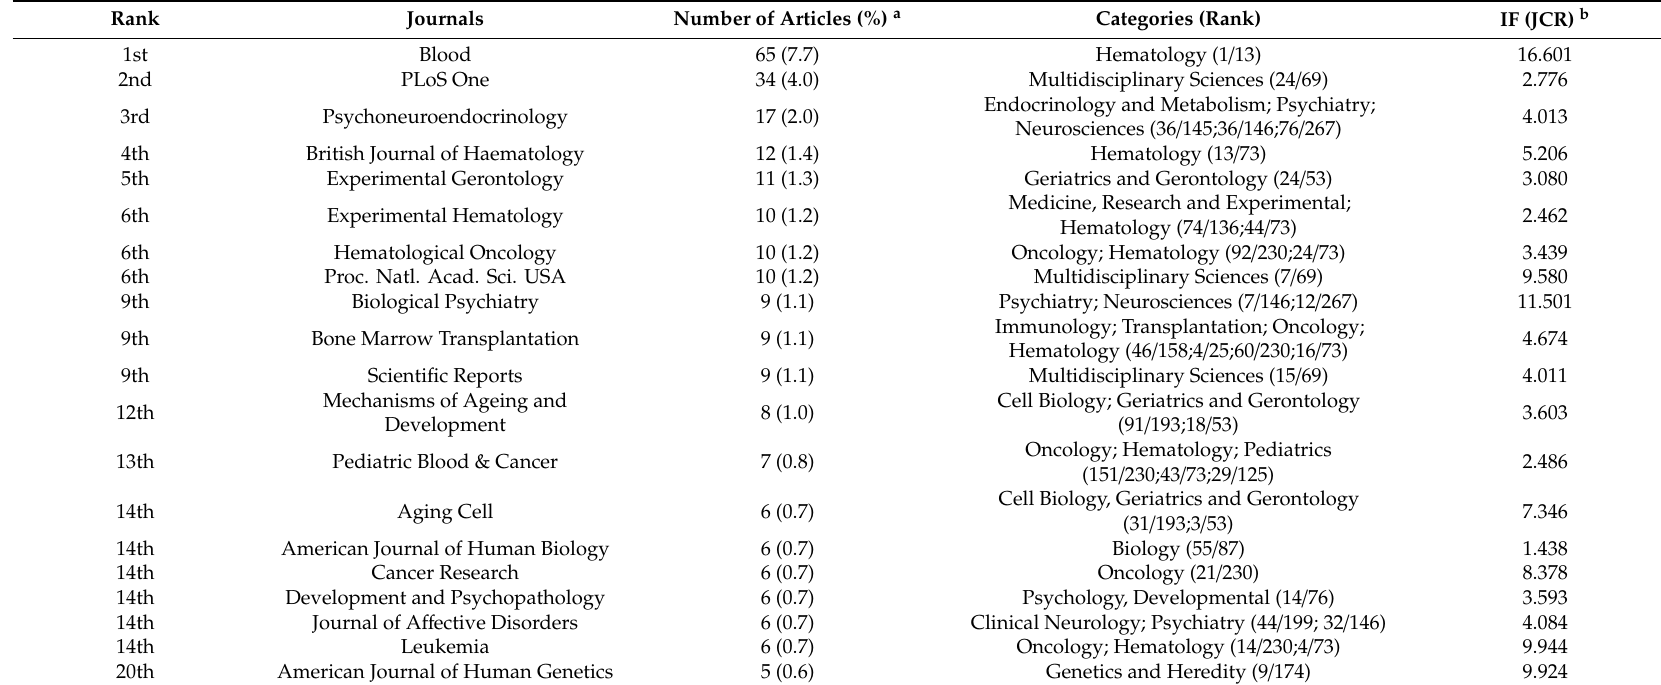
Table 1. Top 20 most prolific journals publishing papers on telomere length in